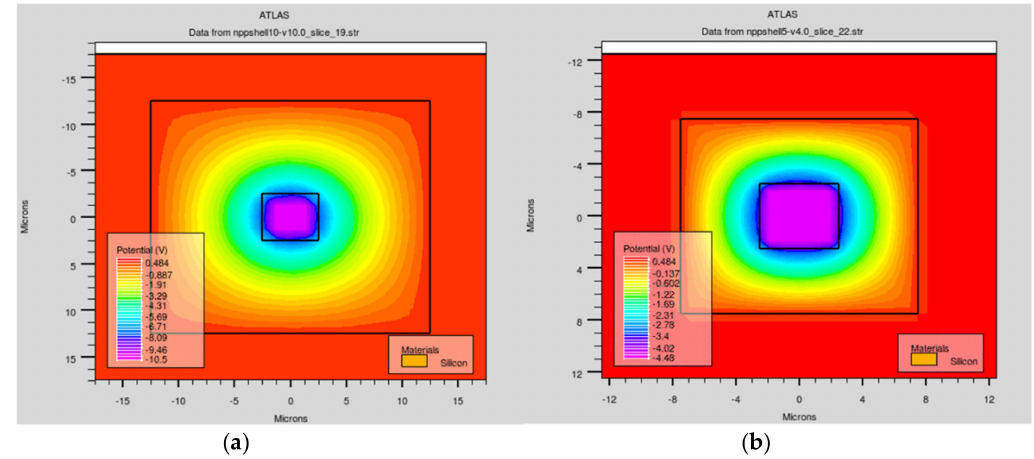
Figure 3. Electric potential profiles along the z -axis when z = 103 µ m with electrode spacings of ( a ) 10 µ m and ( b ) 5 µ m.